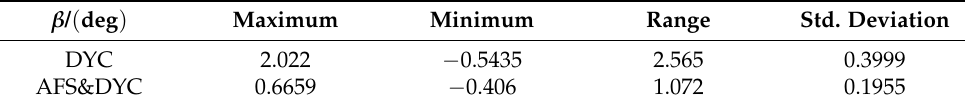
Table 7. Sideslip angle under low adhesion